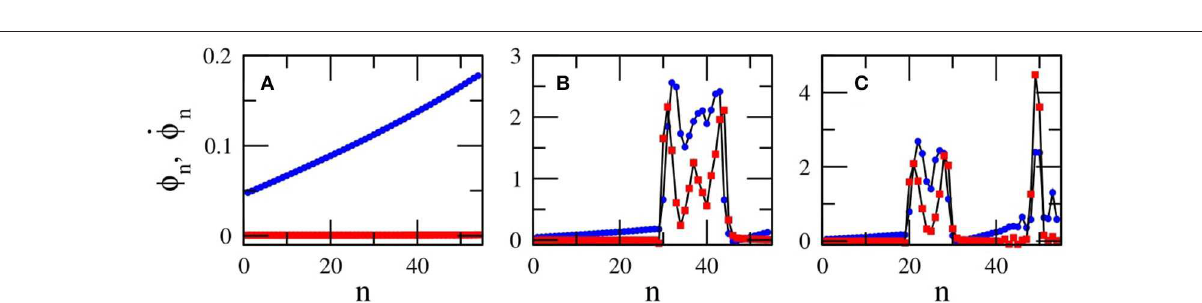
FIGURE 14 | Flux and voltage profiles φ n (blue) and v n (B) φ dc max 0.4, (C) φ dc max =